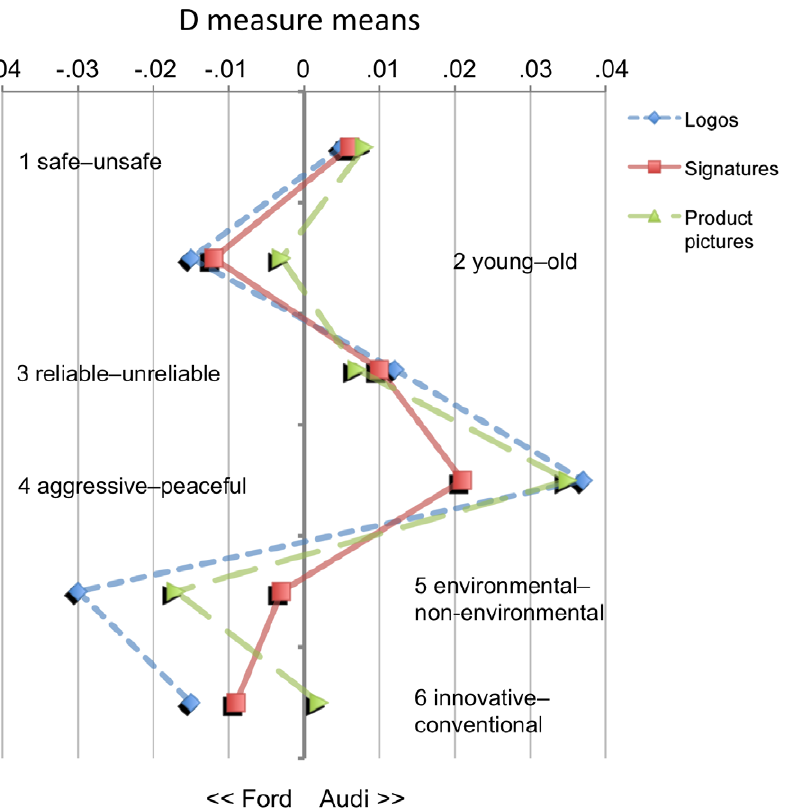
Figure 2. Study 1 (‘‘AUDI vs. FORD’’): D measure means for every single IAT ( N =26) resulting from combinations of the two factors ATTRIBUTE DIMENSION and BRAND CUE.